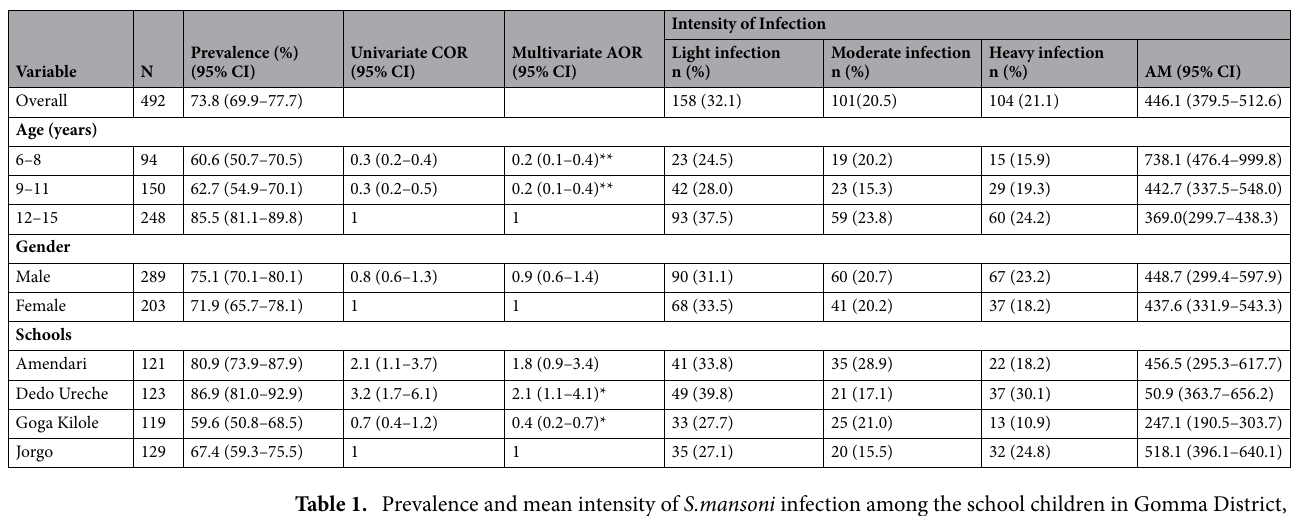
Table 1. Prevalence and mean intensity of S.mansoni infection among the school children in Gomma District, Southwestern Ethiopia. AM arithmetic mean, AOR adjusted odds ratio, CI confidence interval, COR crude odds ratio, N number examined. *Statistical significance at P < 0.05. **Statistical significance at P <